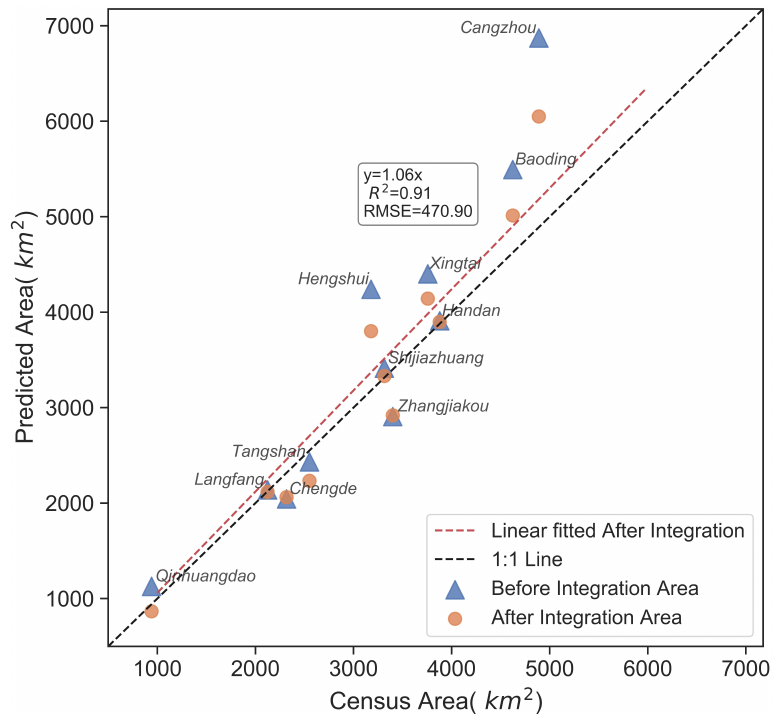
Figure 11. Comparison of the corn area predicted in this research and the census data for each prefecture-level city. The census data were obtained from the HEBEI Economic Yearbook 2017, and the corn area was estimated by subtracting the summer harvest grain area from the cereal